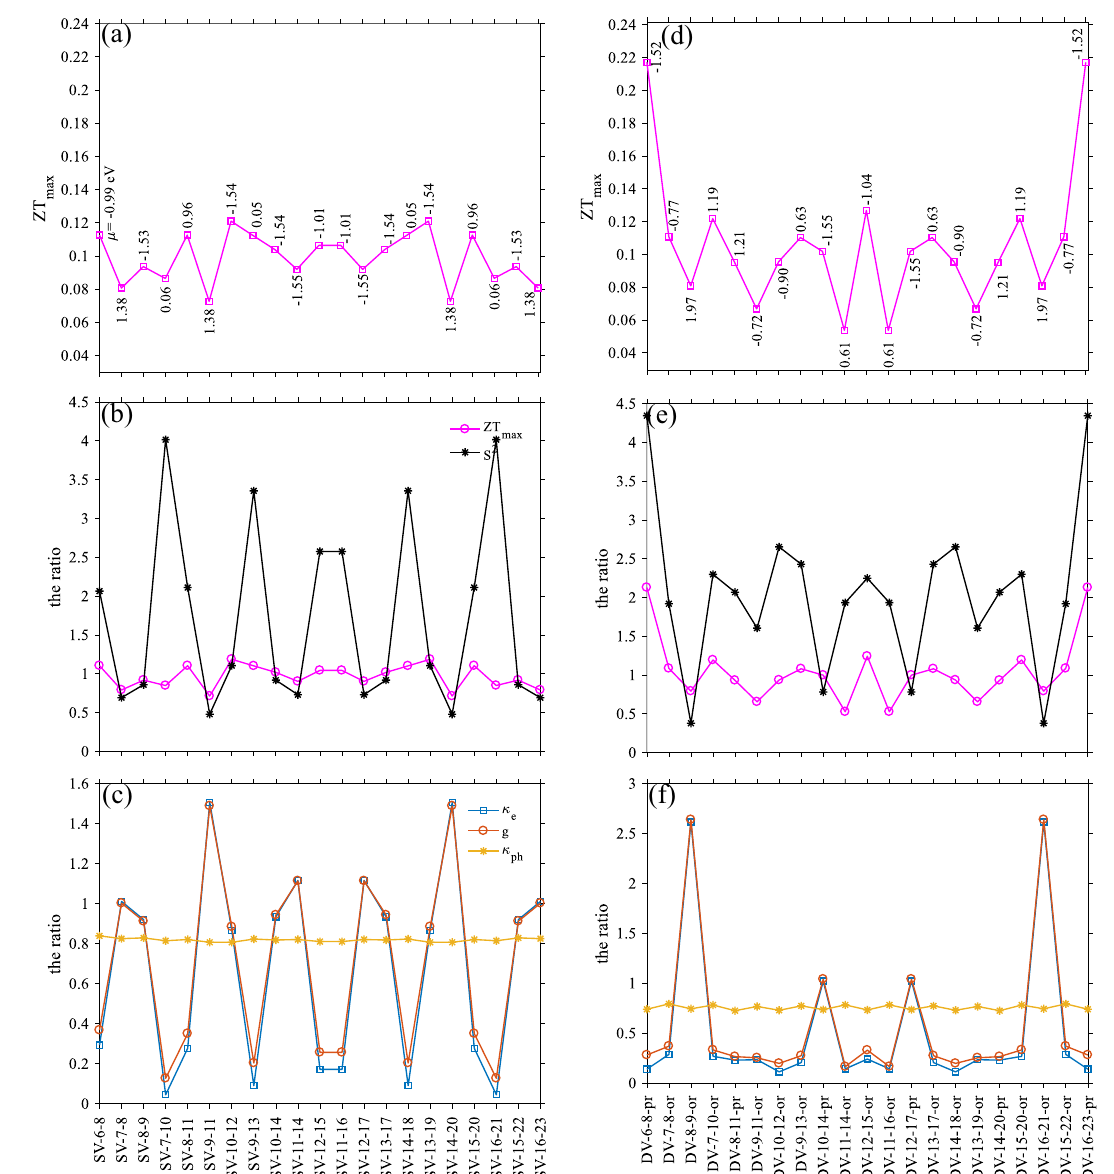
Figure 3. ( a ) Maximum figure of merit for different SV locations together with the corresponding μ, ( b ) the ratio of S 2 and ZT max , ( c ) the ratio of electronic and phononic terms as a function of various SV locations, ( d ) the ZT max with the corresponding chemical potential as a function of different DV locations, ( e ) the ratio of the Seebeck square and the maximum of ZT, and ( f ) the ratio of electronic and phononic terms versus the DV 34.43 Å. The temperature is 350 locations. The device length is L D ≈